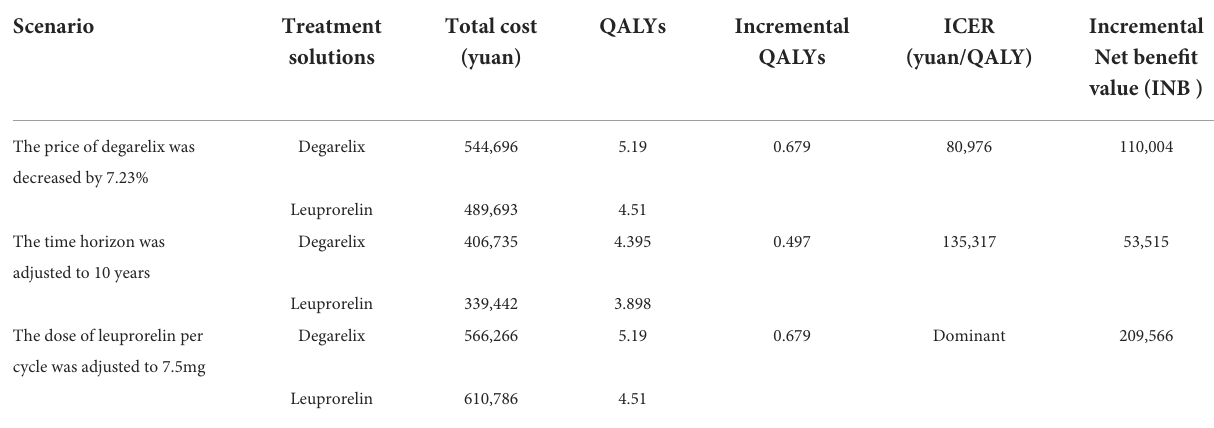
TABLE 10 Results of crowd scenario